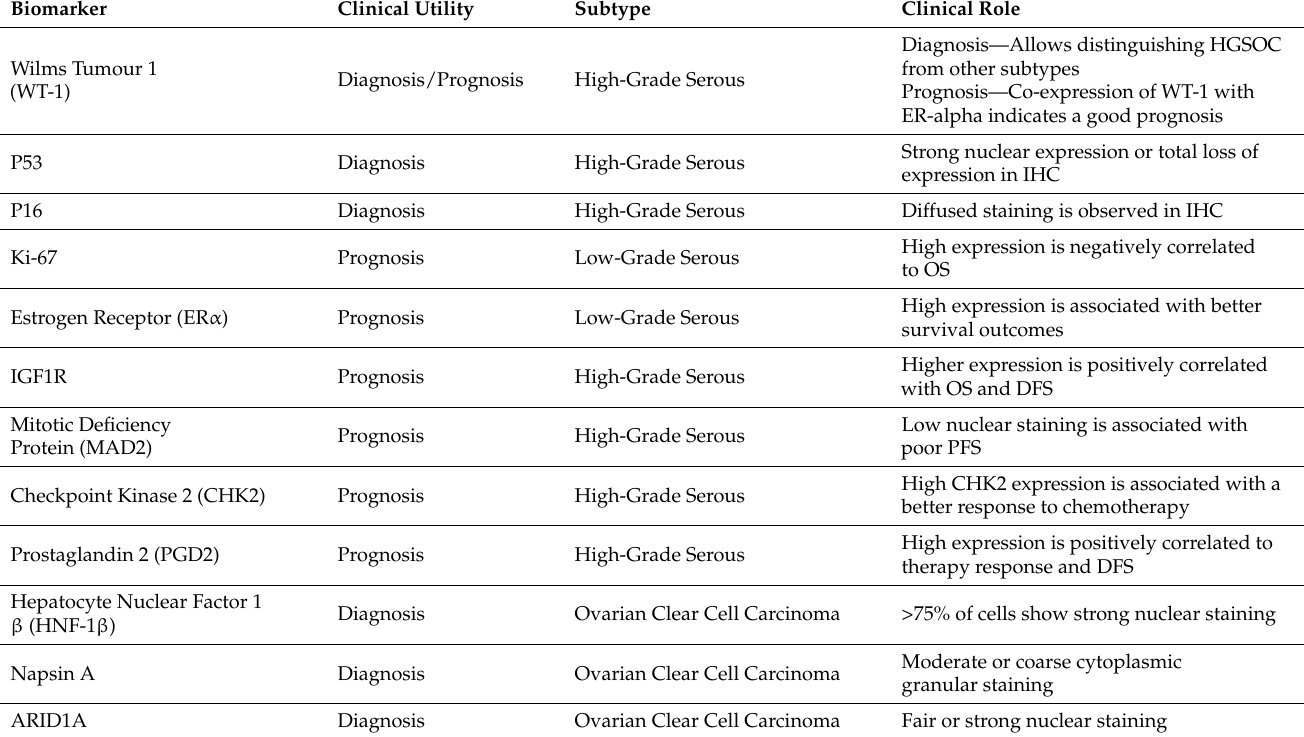
Table 2. List of current IHC-based biomarkers used in ovarian cancer